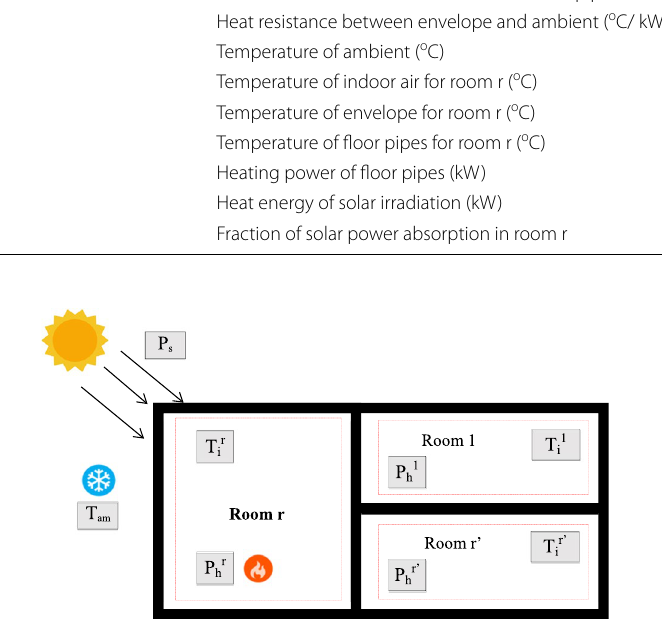
Fig. 1 The schematic structure of the buildings with the nomenclature of thermal dynamics (Golmohamadi et al.